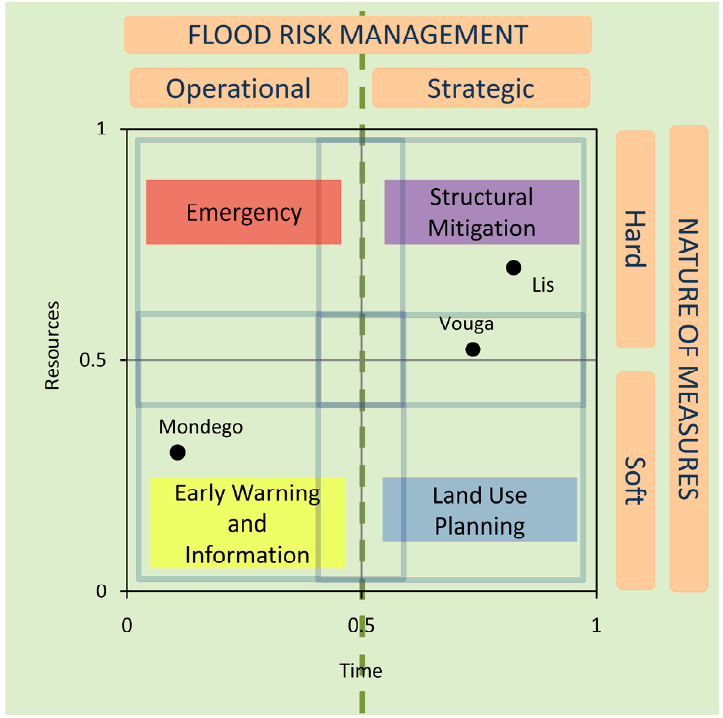
Figure 12. Inference of flood risk management strategies upon the FIS